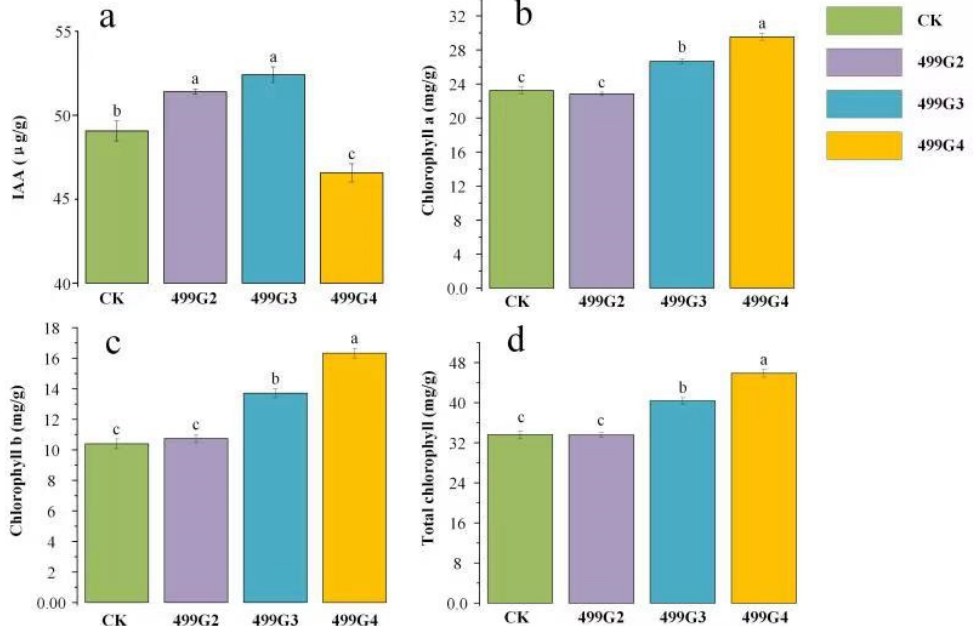
Figure 5. Effects of inoculants on IAA ( a ), chlorophyll a ( b ), chlorophyll b ( c ) and total chlorophyll ( d ) in cultivated rice. Error bars represent standard errors ( n = 3). Different lowercase letters show statistically significant difference ( p value < 0.05).